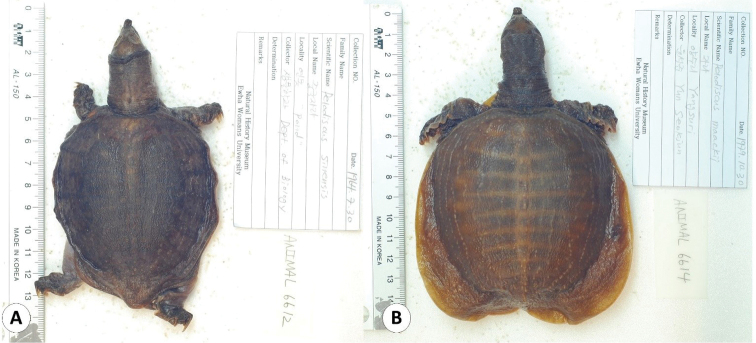
Some of the turtle specimens deposited in the collection of the EWNHMAPelodiscus
chinensis (EWNHM-ANIMAL 6612) BPelodiscus
maackii (EWNHM-ANIMAL 6614).